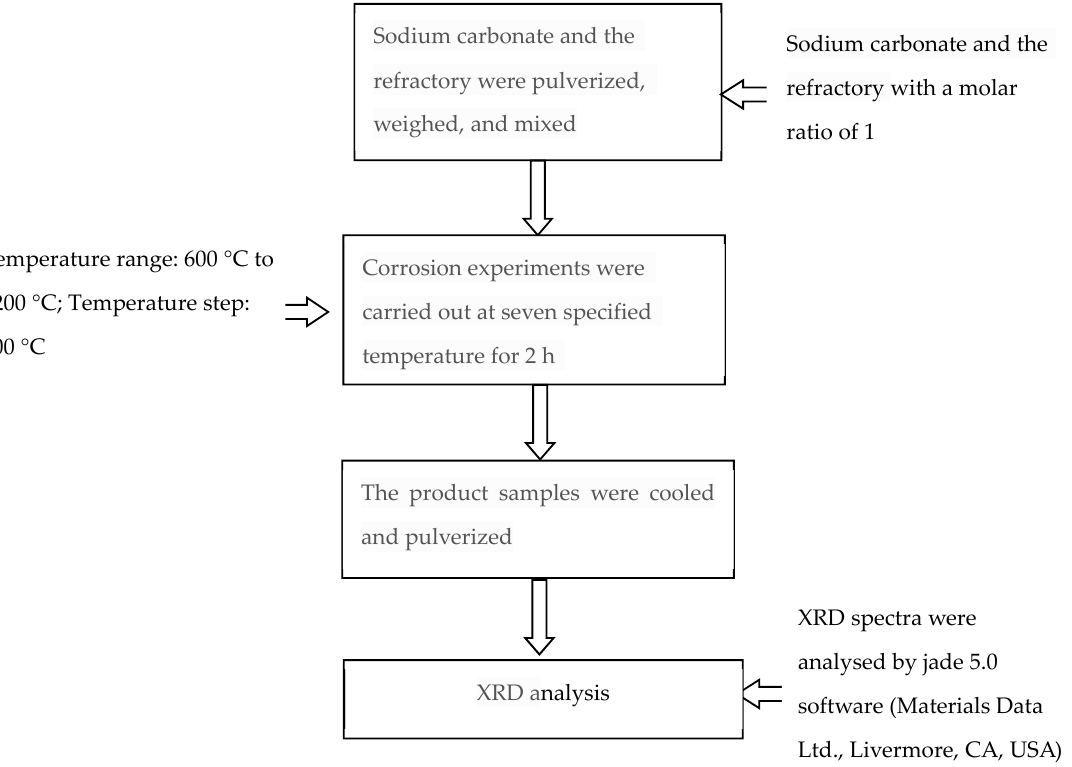
Figure 3. Flow chart of the thermodynamic experiment.